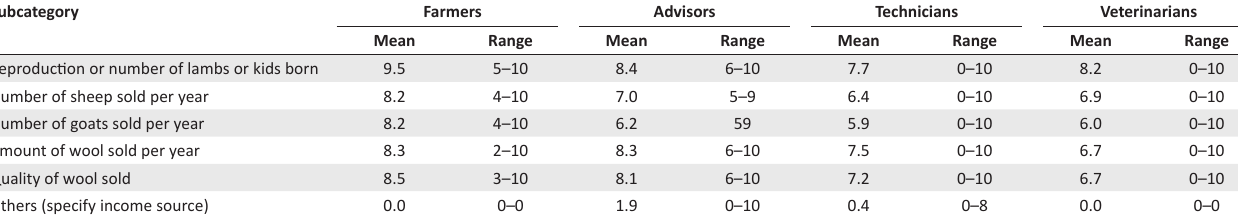
TABLE 7: Importance of production